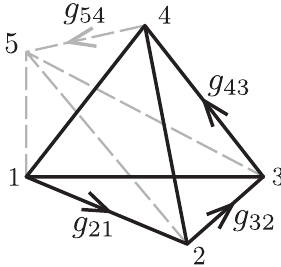
FIG. 4. The 4-cocycle ω assigns a U ð 1 Þ complex number ω ε ð g 54 ; g 43 ; g 32 ; g 21 Þ to a 4-simplex, where 4-simplex, defined as ε ¼ sgn ½ det ð 12 dashed lines represent that the vertex 5 has a different coordinate in the fourth dimension (time) with respect to the other